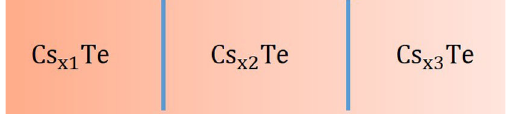
FIG. 6. The schematic of the multiple Cs-Te phases model. The x x x 1 , 2 and 3 in the schematic refer to the chemical ratio. The cathode sample contains several Cs-Te phases, assuming from Cs x 1 Te to Cs x 3 Te the QE increases and the TMS decreases. This can also lead to the negative correlation between QE map and TMS